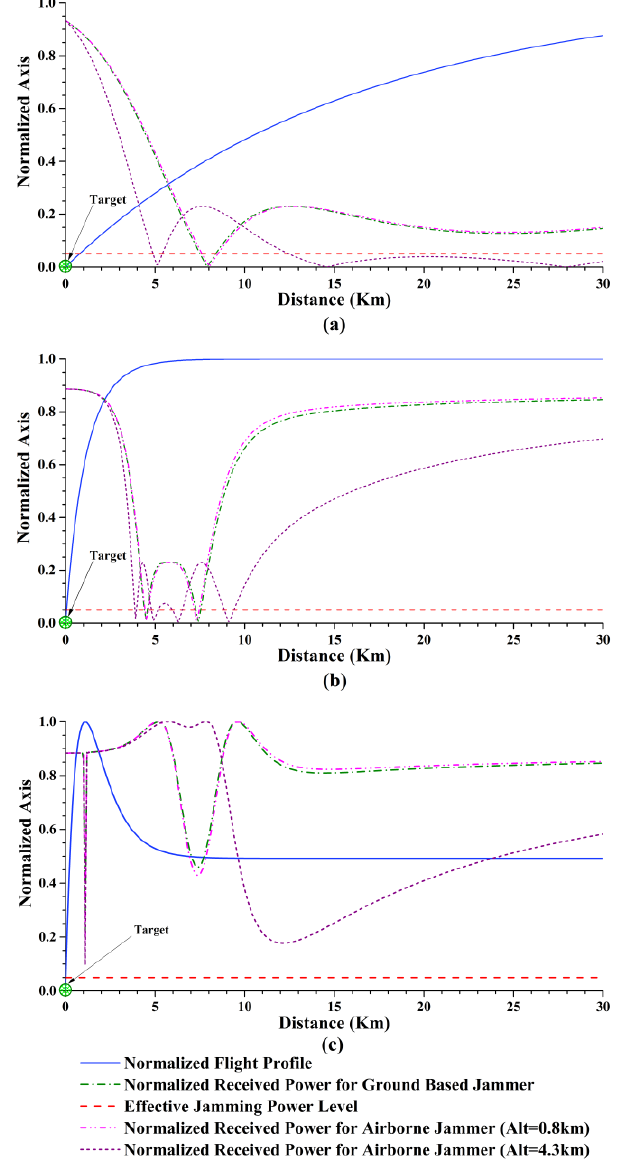
Figure 5. Various scenarios of approach a) Direct Hit, b) Over-Head Hit, c) Enhanced Over-Head Hit